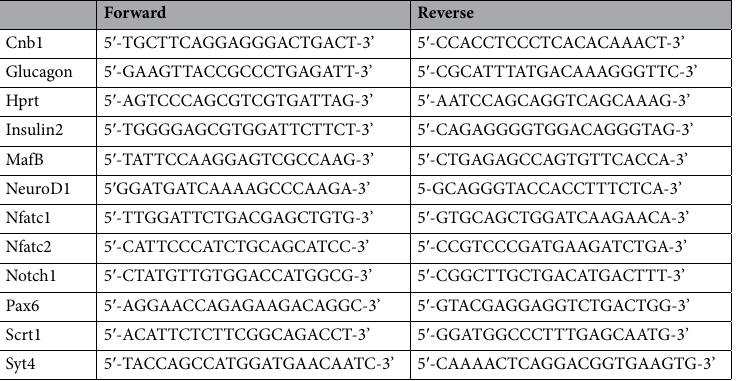
Table 2. qPCR primer sequences (rat).